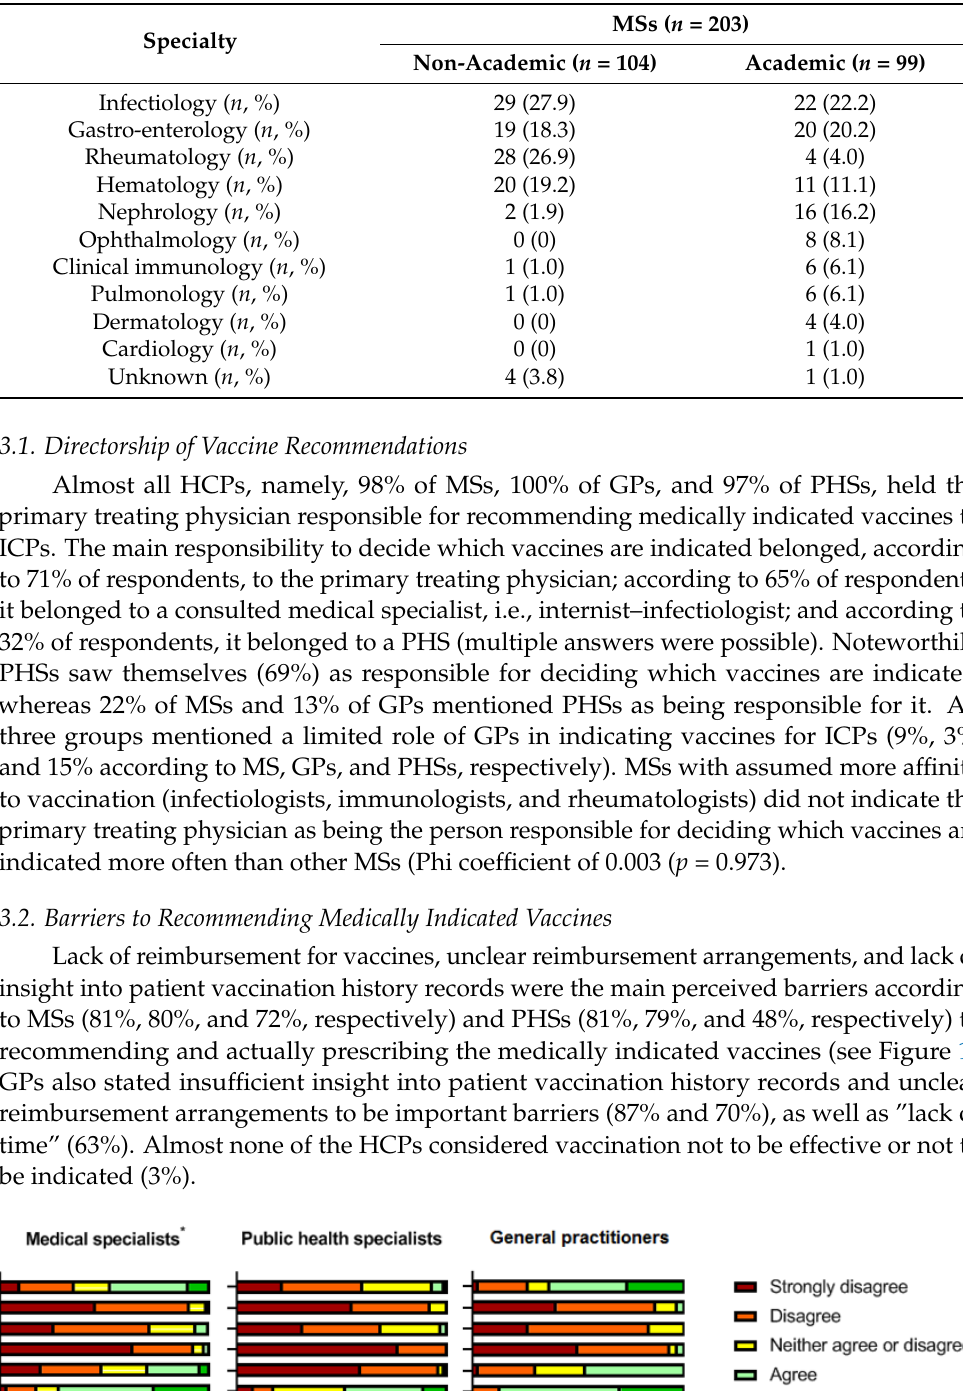
Table 2. Specialties of medical specialists (including nurse practitioners and physician assistants).